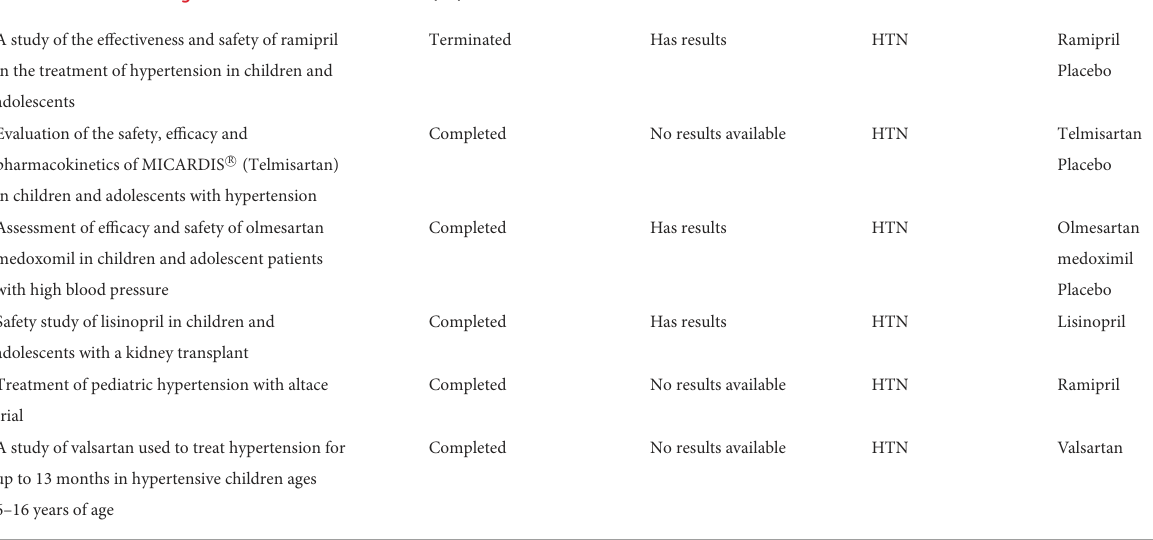
TABLE 4 ClinicalTrials.gov search results 07/05/2022